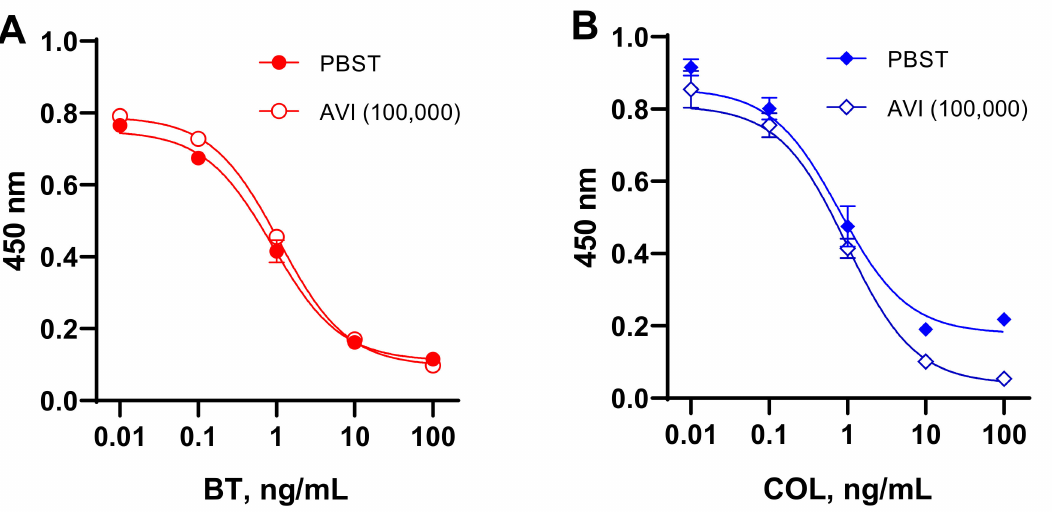
Figure 6. Standard curves for bacitracin ( A ) and colistin ( B ) determination in SAV–B 7 –hapten ELISAs generated in PBST and buffer enriched with avidin (AVI) at 100,000 ng/mL.